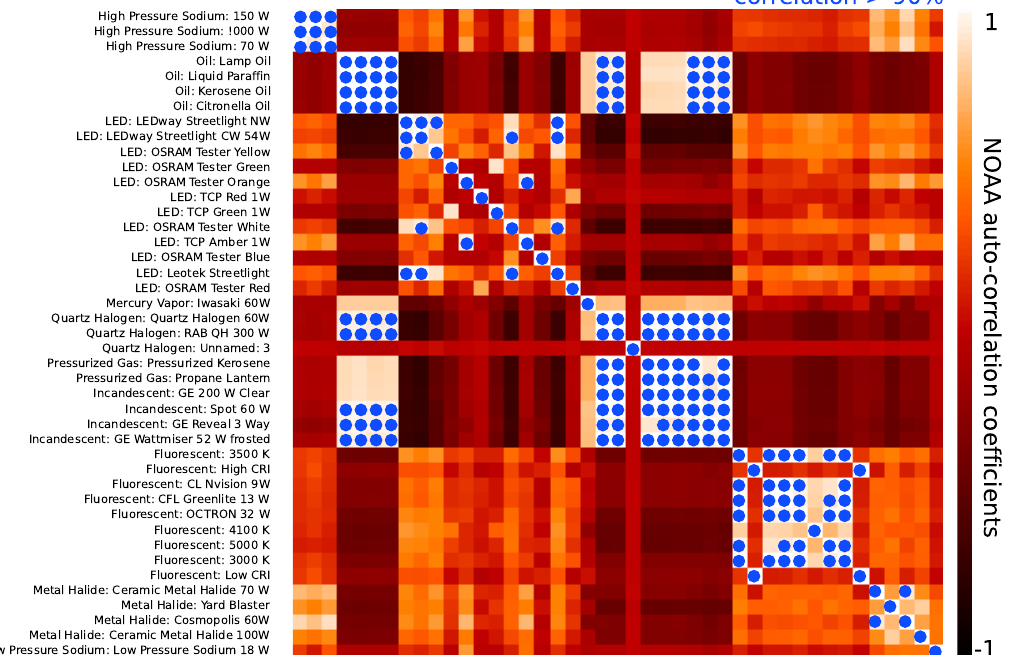
Figure 8. The auto-correlation matrix of the spectra shown in Figure 7. The high correlation between multiple examples of various lighting technologies (and in several cases between lighting technologies) implies that correlations with our spectra will only be able to identify type and not specific examples within a given type when correlating against the NOAA templates.